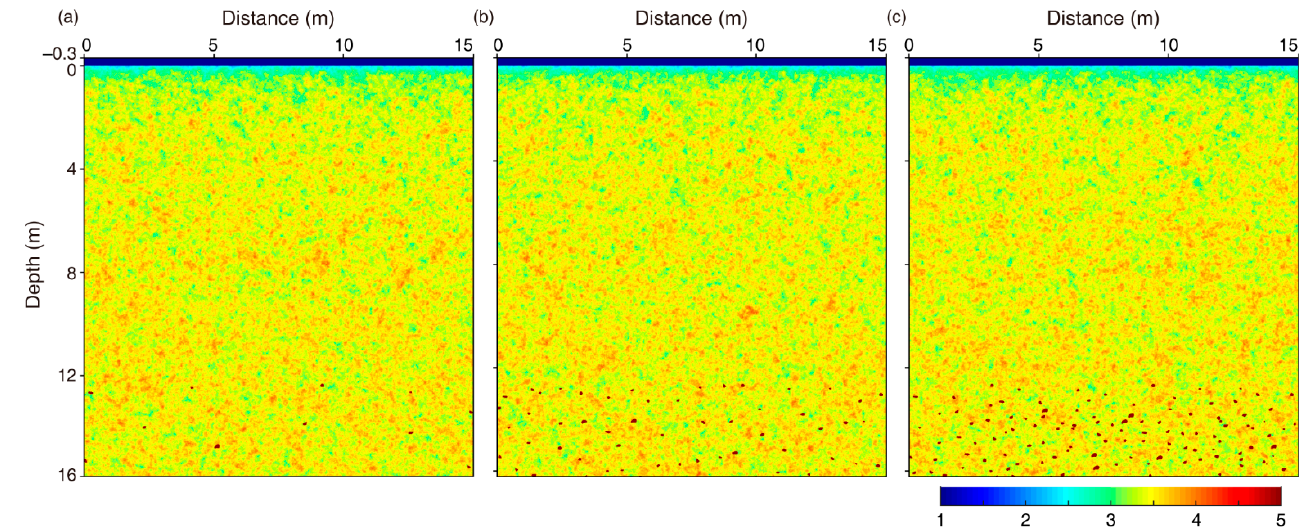
Figure 8. The simulated LPR profiles using the models shown in Figure 7. ( a ) Without rocky blocks; ( b ) with ~20 cm rocks; ( c ) with a ~1 m rock.